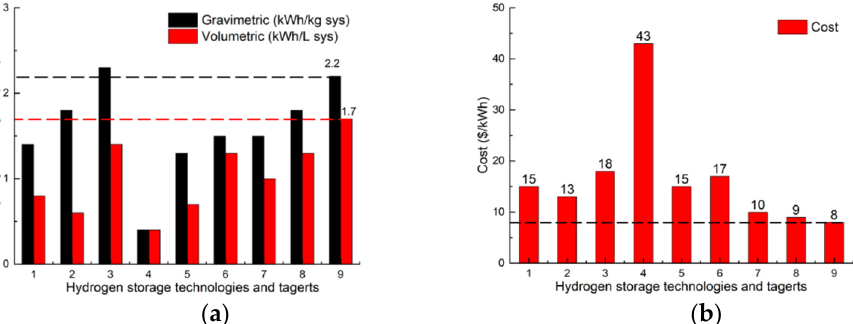
Figure 12. Projected performance of hydrogen storage systems ( a ) comparison of hydrogen storage capacity; ( b ) comparison of cost, projected to 500 k units/yr. (1:700 bar compressed Type IV; 2: 300 bar compressed Type IV; 3: 500 bar cryo-compressed; 4: metal hydrideNaAlH 4 /Ti; 5: Sorbent MOF-5,100 bar; 6: Chemical storage, AB liquid; 7: 2020 target values; 8: 2025 target values; 9: ultimate target values).